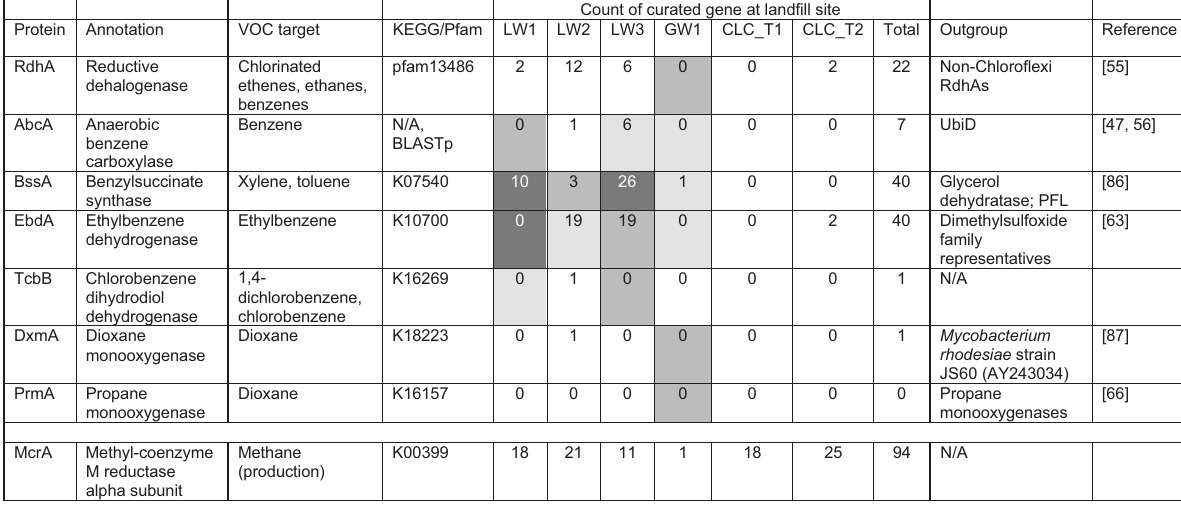
Count of curated gene at landfill site